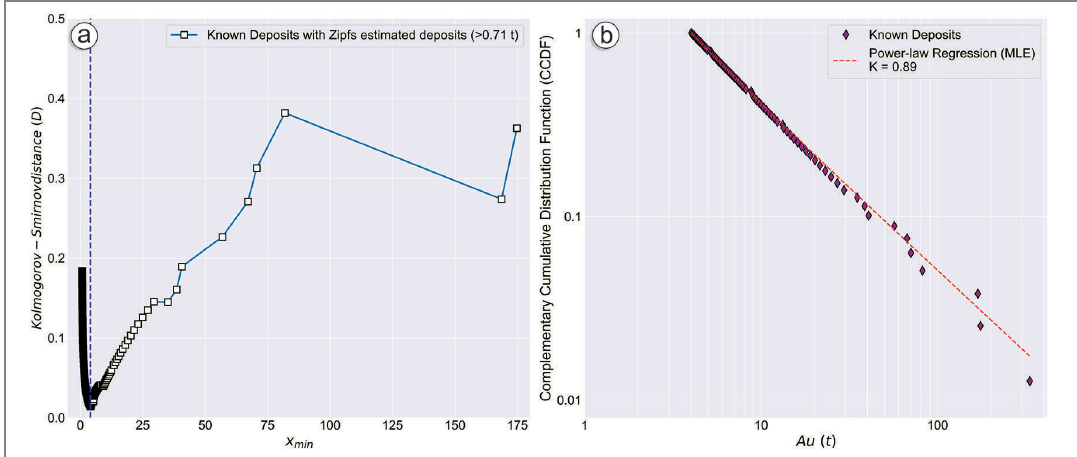
FIGURE 4 - a) Kolmogorov-Smirnov’s distance for the known deposits aggregated with Zipf’s estimated deposits. The minimum of the function =4. b) The log-log plot between the Complementary Cumulative Distribution Function (CCDF) and (dashed vertical blue line) stands when x min the filled deposits. The dashed red line shows the power-law regression using the Maximum Likelihood Estimator (MLE) with k = 0.89.